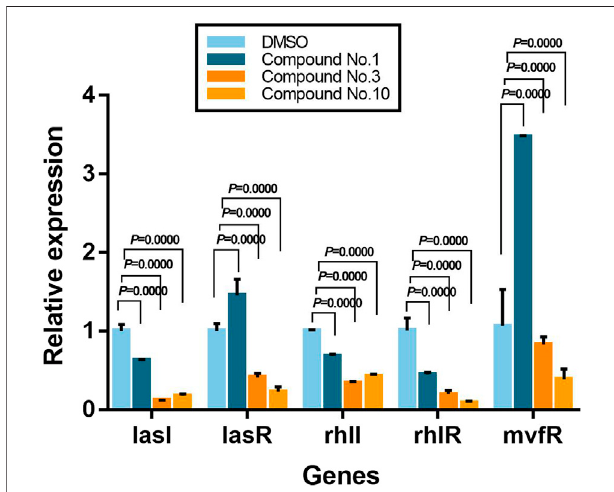
FIGURE 8 | Relative expression levels of QS-regulated genes in the presence of compound no.1, compound no.3, and compound no.10 as determined by real-time quantitative PCR.